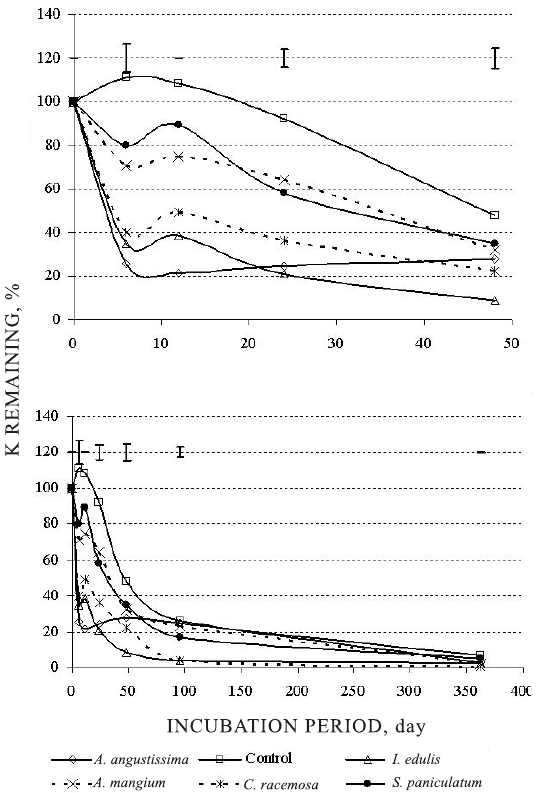
54Figure 5. Percentages of K remaining in mulch from different enriched legumes trees and natural fellow as control, for 48 and 362 days of incubation period. Bars represent LSD with p <